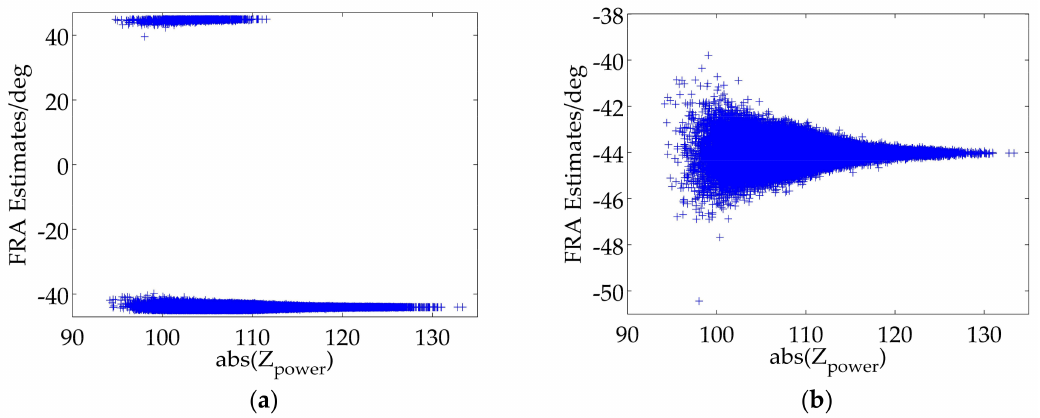
Figure 9. ( a ) FRA estimates as the true FRA is set to 46 ◦ ; ( b ) FRA estimates after pixel-level correction as the true FRA is set to 46 ◦